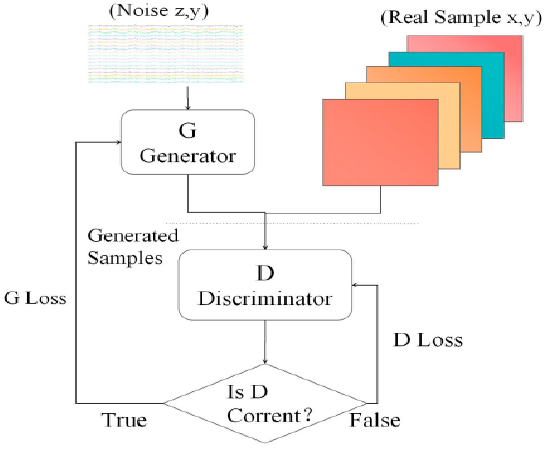
Figure 2. CWGAN structure.